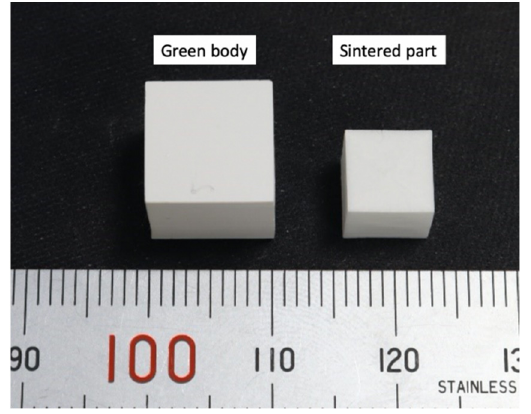
Figure 11. The difference in the dimensions of the printed green body ( left ) and the sintered part ( right ).